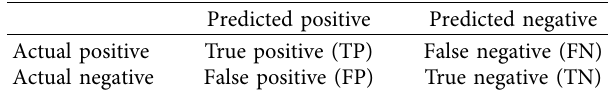
Table 3: Confusion matrix. Table 4: Parameter tuning